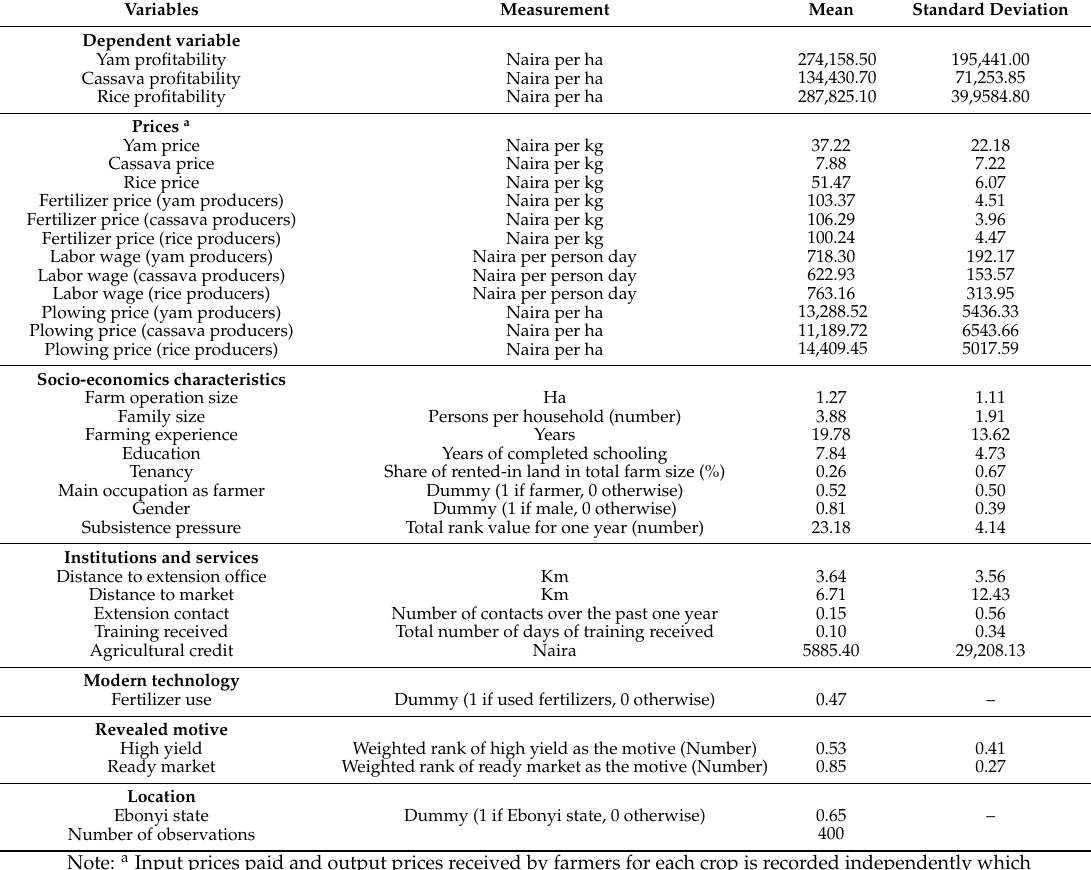
Table 2. Definition, measurement and summary statistics of the variables used in the econometric